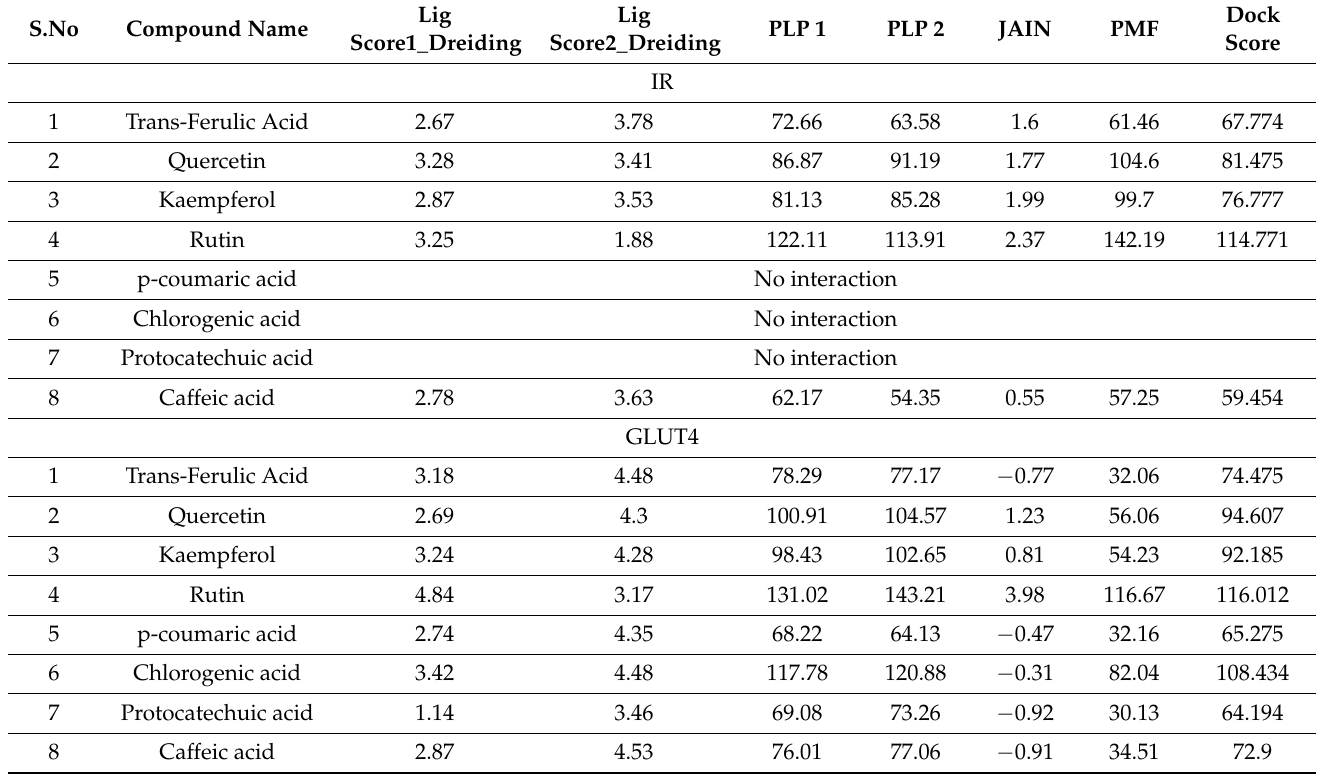
Table 5. Binding affinity assessment based on the dock score proposed natural compounds and selected target proteins (IR and